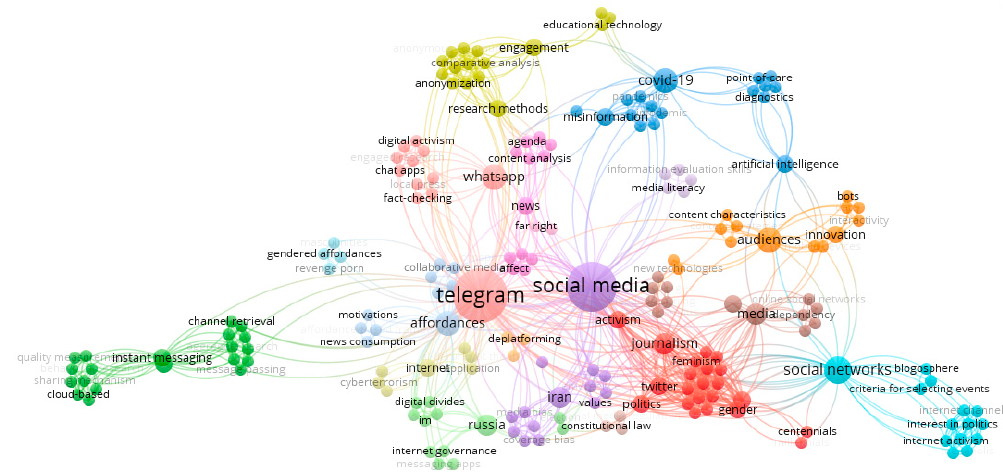
Figure 1. Co-occurrence network map of keywords. Sources: WOS & Scopus.